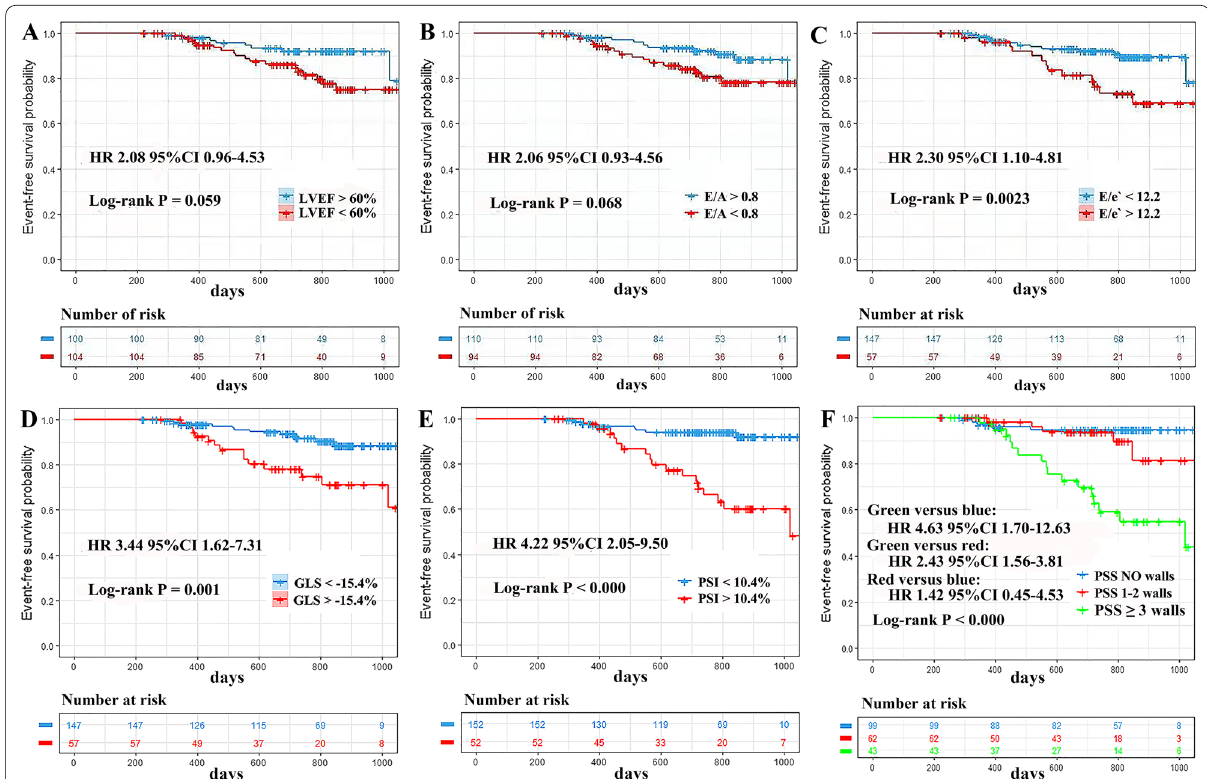
Fig. 2 Event-free survival. Kaplan–Meier survival curves for adverse events prediction by ( A ) LVEF; ( B ) E/A; ( C ) E/e ′ ; ( D ) GLS; ( E ) PSI; ( F ) the number of left ventricle walls with PSS. LVEF: left ventricular ejection fraction; E/A: mitral inflow peak early velocity/mitral inflow peak late velocity; E/e ′ : mitral inflow peak early velocity/mitral annular peak early velocity; GLS: global longitudinal strain; PSI: post-systolic index; PSS: post-systolic